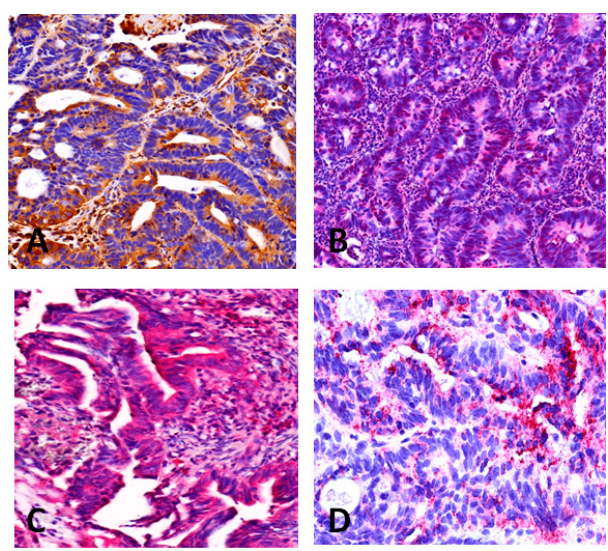
Figure 1. Immunohistochemical validation of protein expression in colorectal carcinoma biopsy tissue identified by isotope coded protein label (ICPL); ( A ) Plectin-1; ( B ) Transketolase; ( C ) Transgelin; ( D ) HADHA Trifunctional enzyme subunit α , mitochondrial